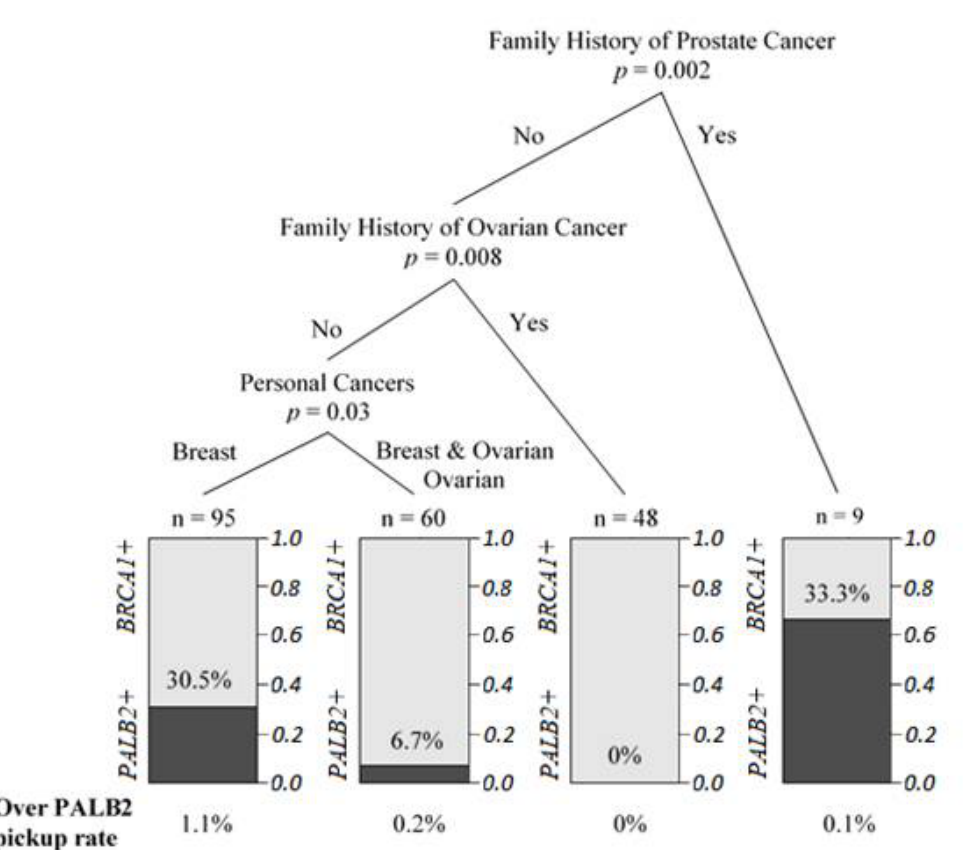
Figure 3. Regression tree for prediction of probability to find PALB2 pathogenic mutation carriers from BRCA1 carriers.